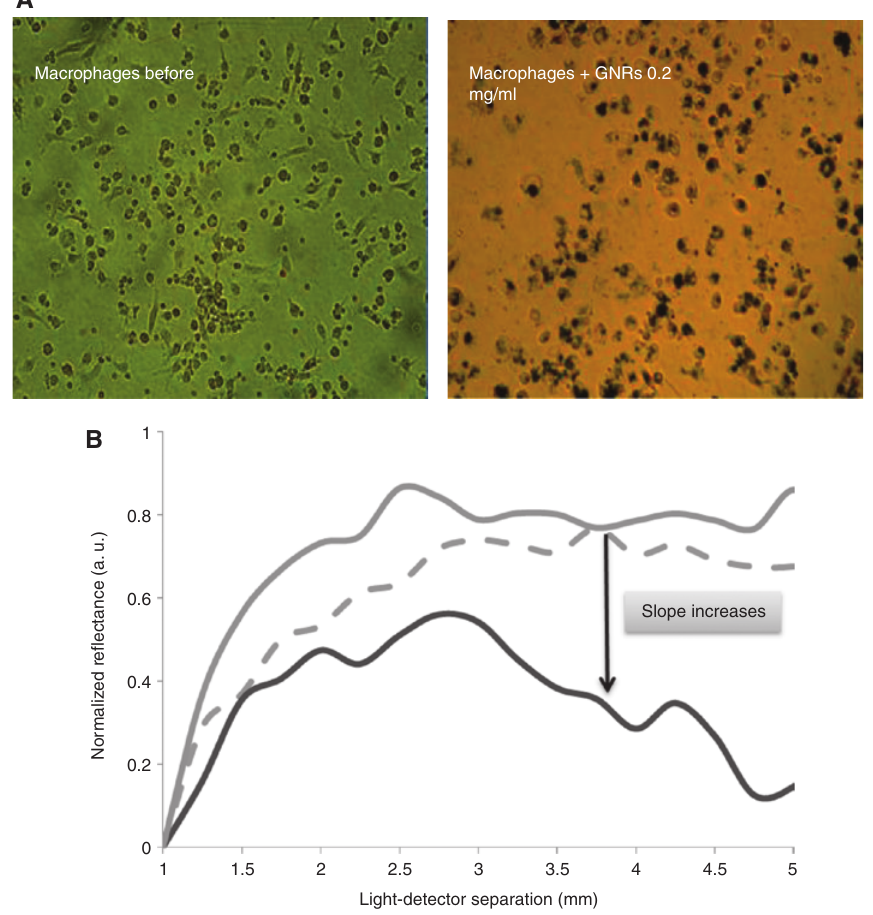
Figure 6: Atherosclerosis unstable plaques detection based on DR-GNRs measurements. (A) GNRs uptake by macrophages captured by the hyperspectral microscopy. Nanoparticles appear as dark dots within cells due to light absorption by the particles. (B) Normalized diffusion reflection curves of a rat balloon-injured carotid artery measured by our DR technique. The dashed line represents the reflection from the injured artery before the GNRs